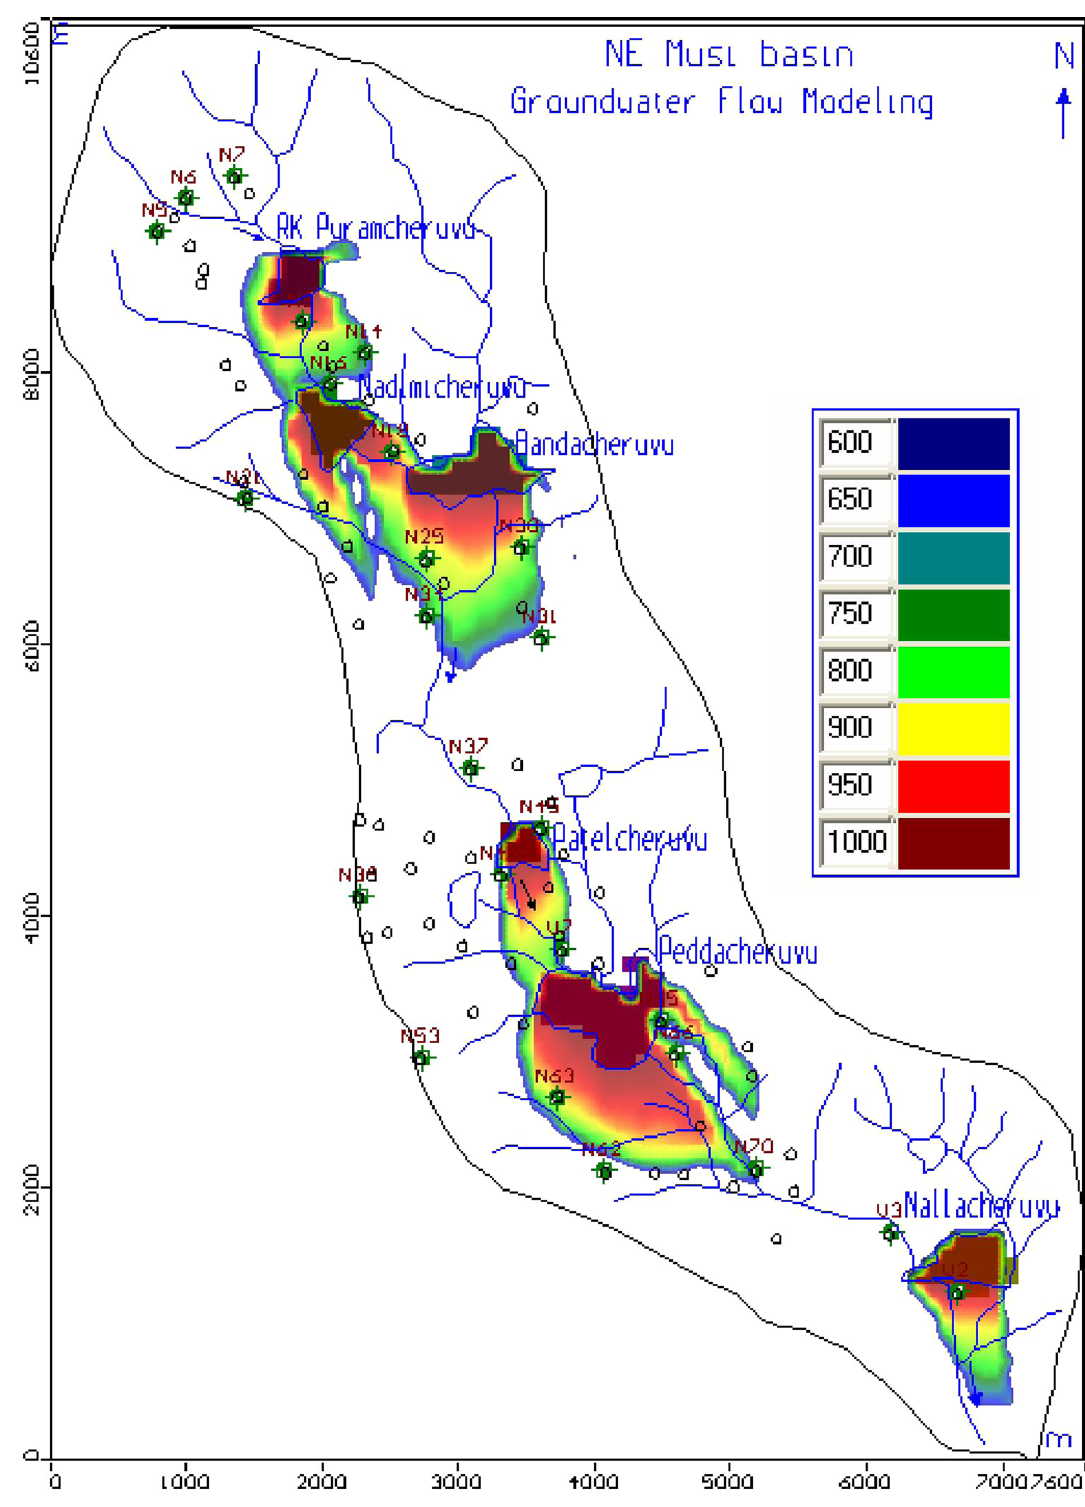
Fig. 10 TDS concentration of first layer in and around the lake for